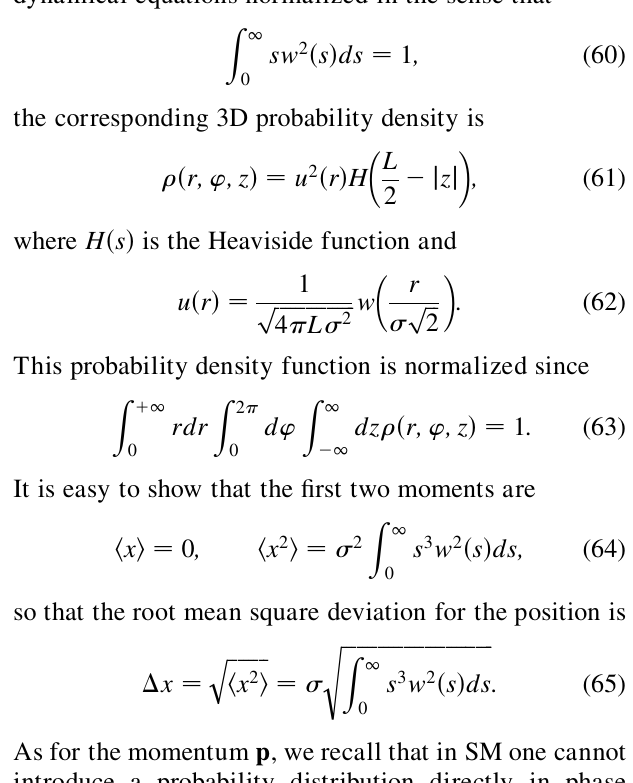
FIG. 5. Three-dimensional view of the transverse distribu- p (cid:1)(cid:1)(cid:1)(cid:1)(cid:1)(cid:1)(cid:1)(cid:1)(cid:1)(cid:1)(cid:1)(cid:1)(cid:1)(cid:1)(cid:1)(cid:1) (cid:3) for a space-charge strength of (cid:7) (cid:21) 22 : 5 . x 2 (cid:5) y 2 tion w 2 (cid:2)